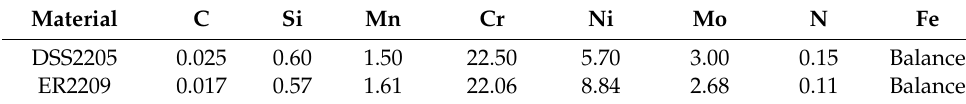
Table 1. Chemical composition of DSS 2205 plate and ER2209 solid wire (wt%). Material C